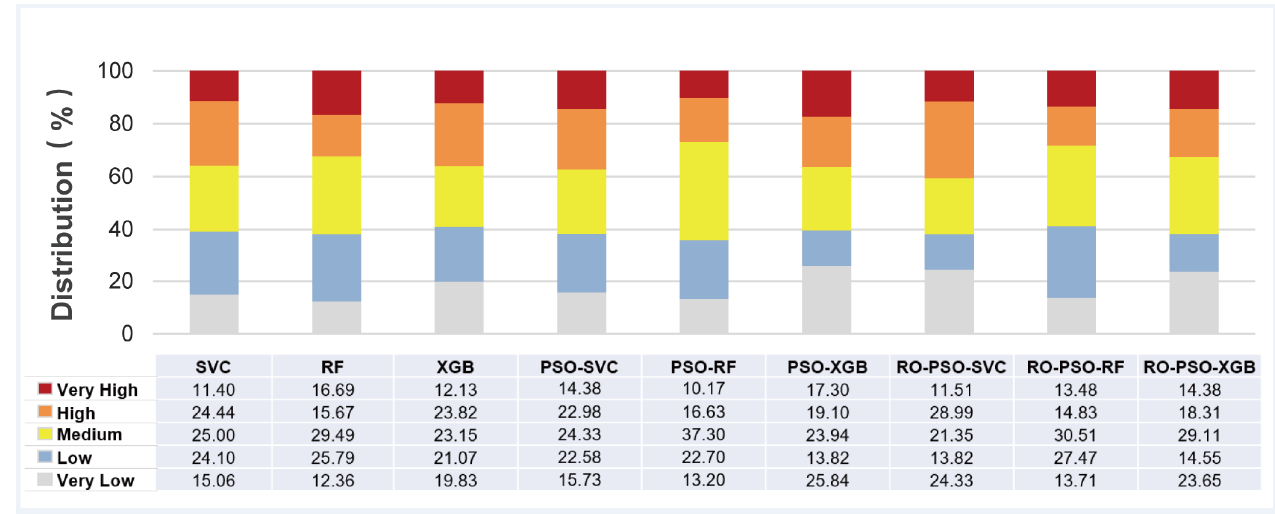
Figure 11. Proportions of the different debris susceptibility levels among the hybrid or non-hybrid models.